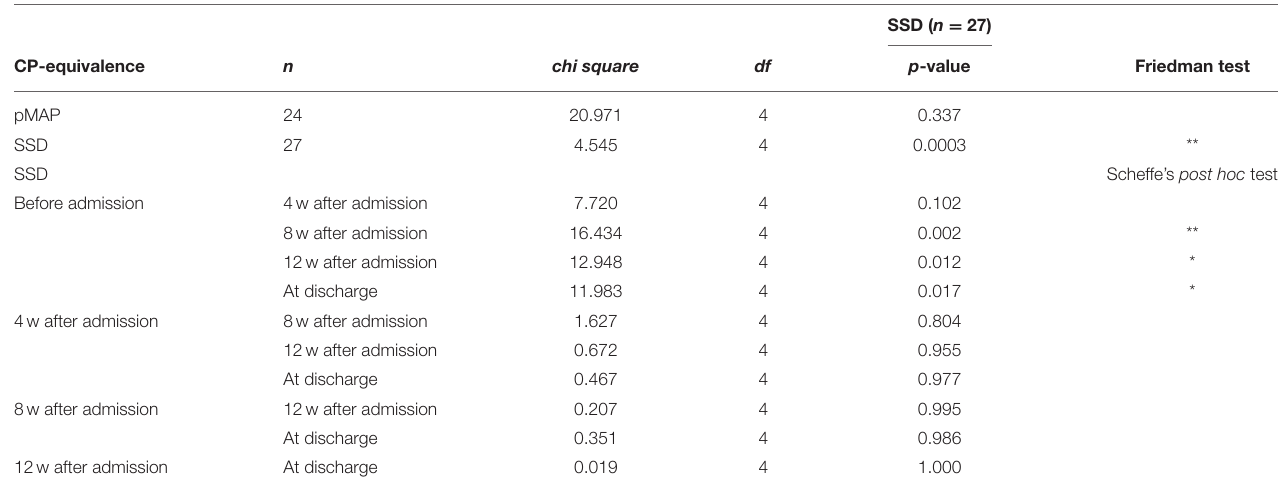
TABLE 4 | Changes of CP-equivalence value of pMAP and SSD over